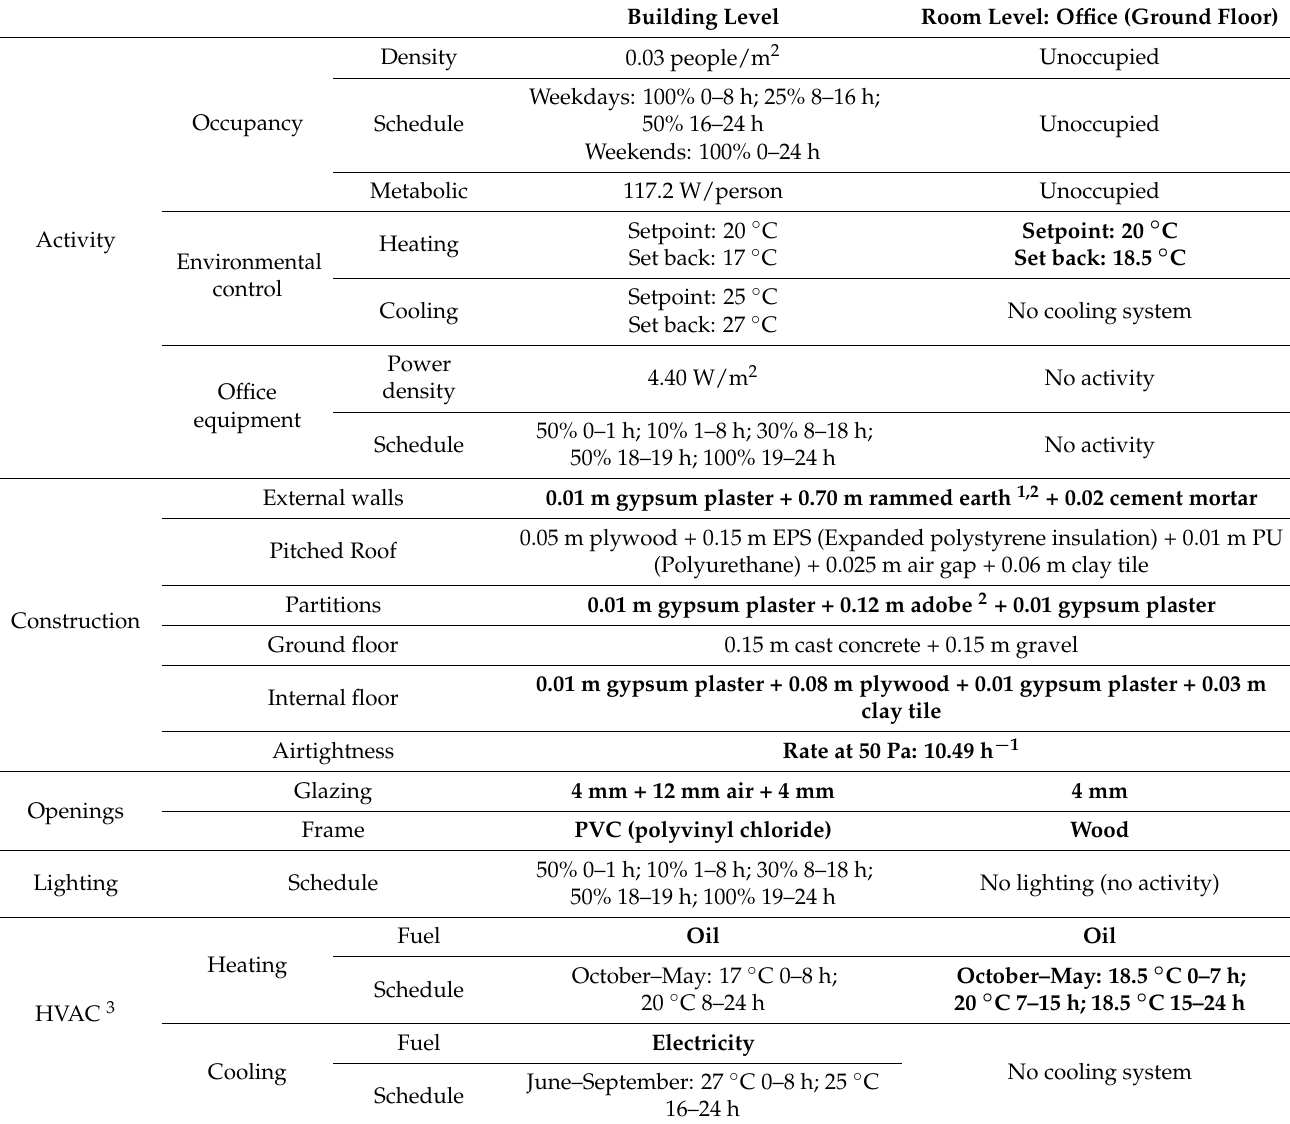
Table 2. General information introduced in DesignBuilder and used in all simulations. In bold: actual data from